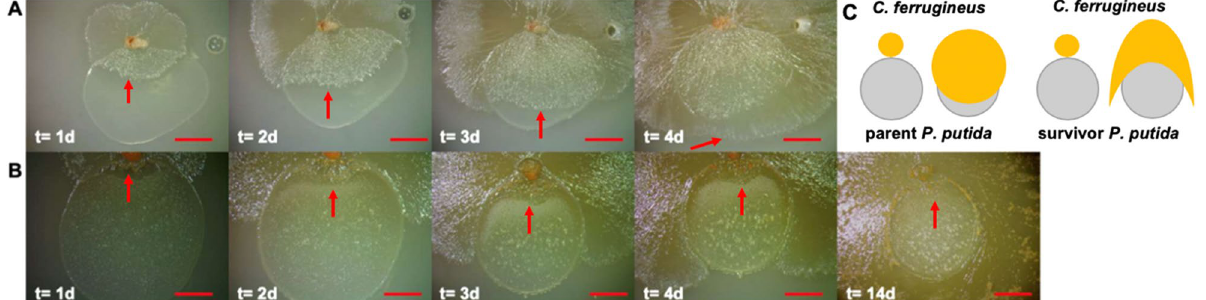
Figure 4. Survivor P. putida maintains predator avoidance trait on nutrient rich media. ( A ) 4 day sequence of C. ferrugineus predation of parent P. putida on nutrient-rich VY/2 media depicting complete swarming of prey lawn (t = d4); red arrows indicate C. ferrugineus swarm edge progression into parent P. putida lawn. ( B ) 4 day sequence depicting predator avoidance observed from survivor P. putida lawn on nutrient-rich VY/2 media including an additional image from day 14 to demonstrate length of avoidance; red arrows indicate C. ferrugineus swarm edge progression into survivor P. putida lawn. ( C ) Cartoon depicting difference in C. ferrugineus swarming patterns between parent P. putida ( A ) and survivor P. putida ( B ). All scale bars depict 1